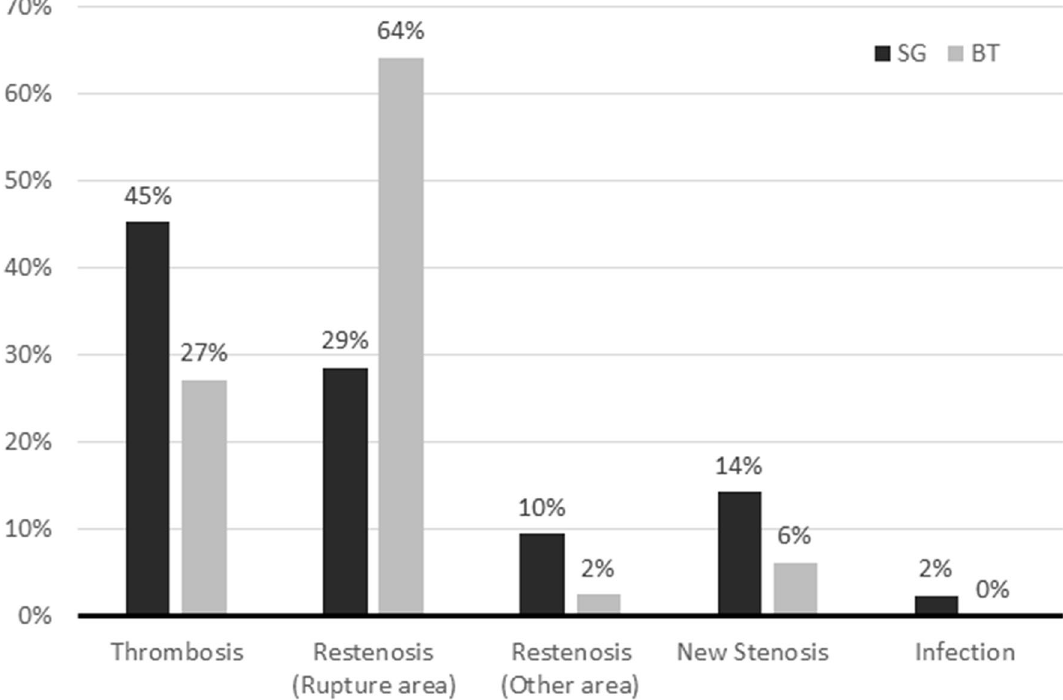
Figure 3. Proportions of patients with different causes of primary access circuit failure, stratified by the treatment modality for ruptured vessels. SG, stent graft; BT, balloon